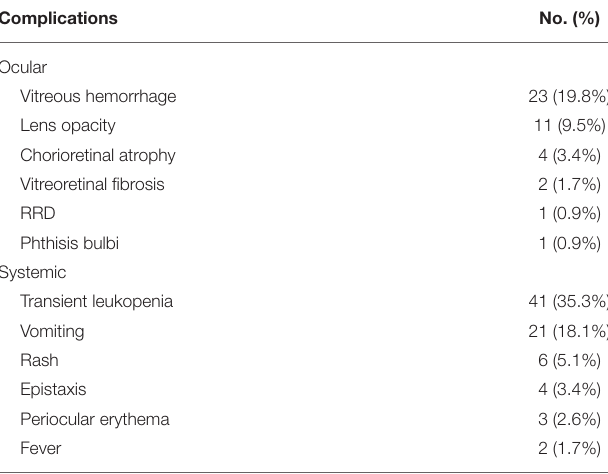
TABLE 3 | Treatment